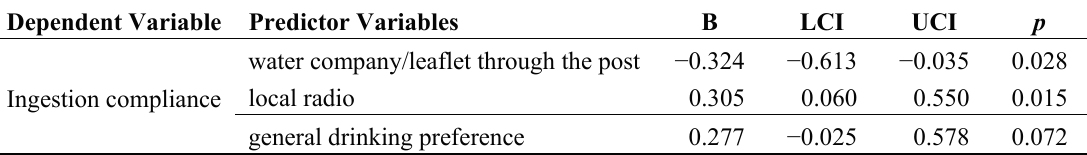
Table 8. Linear Regression with final predictor variables of compliance with advice on ingestion.